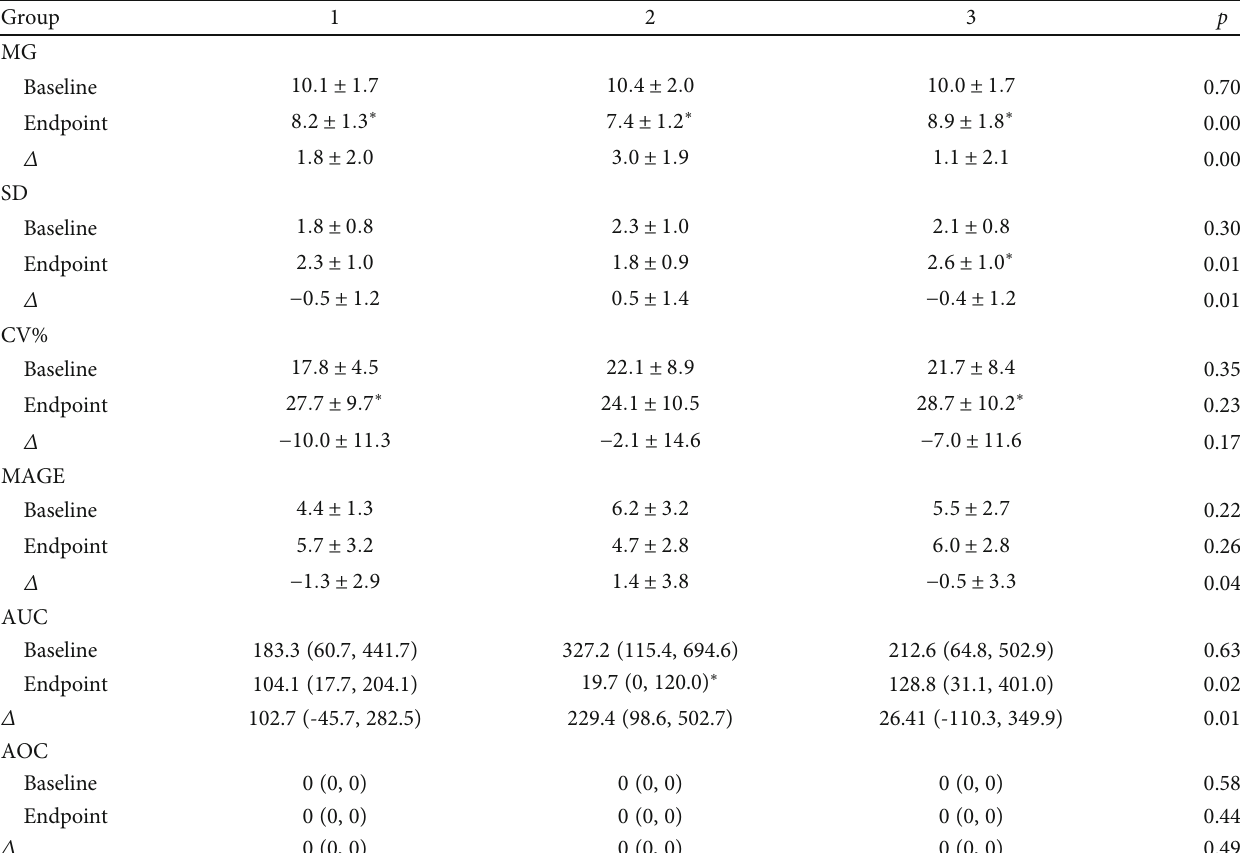
Table 5: The CGM pro fi le of the three groups.